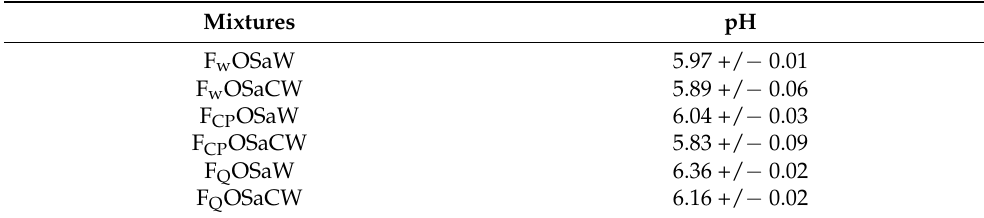
Table 3. pH of the different sponge cake